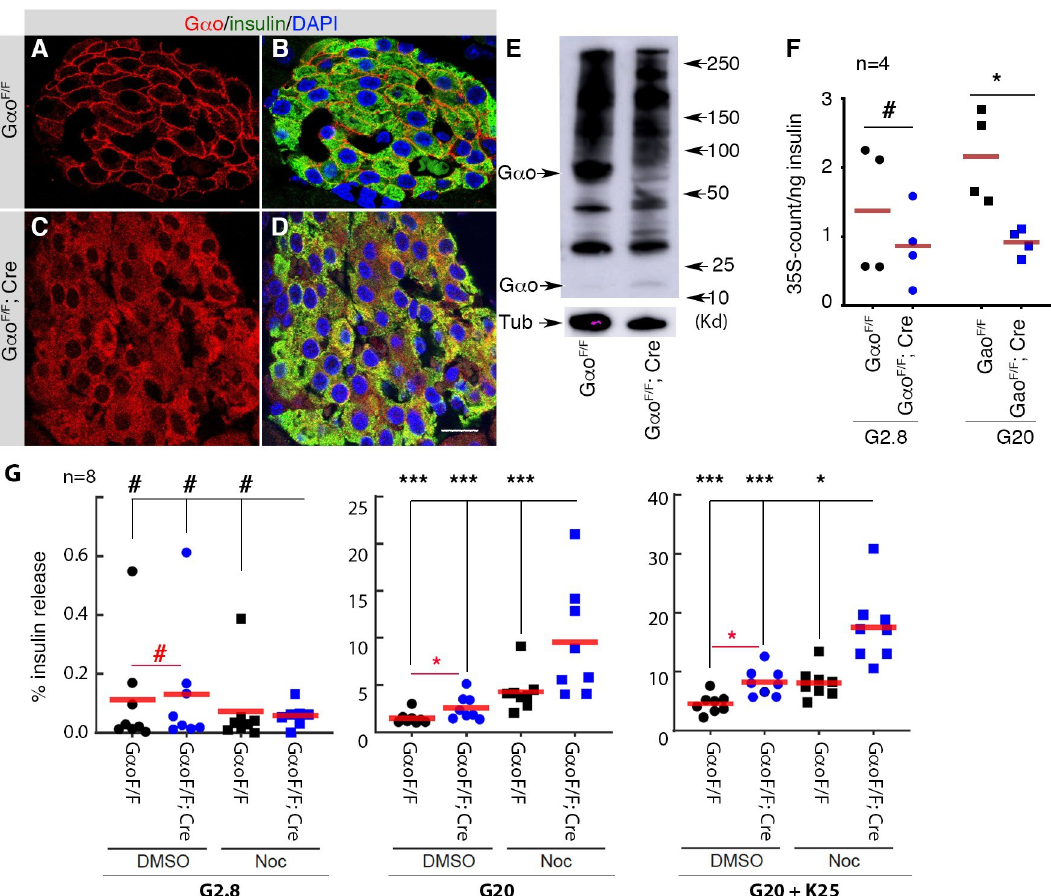
Fig 4. G α o and MT regulate SG secretion via parallel pathways. (A-E) Immunofluorescence and western blot showing G α o inactivation in G α o F/F ; Pdx1 Cre islet cells. Note that Cre-mediated G α o F deletion will yield a mRNA that translates a short N-terminal G α o peptide, recognized by the antibody (red) but has no detectable biological effect [18]. Full length funtional G α o is membrane- bound, while the N-terminal fragment is cytoplasmic, allowing for ready verification of Pdx1 Cre -mediated G α o inactivation in insulin + (green) cells. DAPI (blue) stained for nuclei. Scale bar, 20 μ m. In (E), note the disapearance of G α o full length protein and the appearance of a short G α o fragment in the G α o F/F ; Pdx1 Cre islet samples. Alpha-tubulin was used as loading controls for the western blot. (F) The levels of 35 S-labeling in secreted insulin from control and � : p < 0.05; �� : p < 0.01; ��� : p < 0.001) β cells, prelabeled for four hours. (G) Insulin secretion from G α o F/F ; Pdx1 Cre islets, with or without NOC-treatment, induced by basal G2.8, stimulating G20, and KCl-induced depolarization [(A, B) G20 + K25 (25 mM KCl)]. P values, results from multi-comparison ANOVA or one-way ANOVA (#: p > 0.3. � : p < 0.05; �� : p < 0.01; ��� : p < 0.001). Note the red font “#” or “ � ” in (G) highlight the differences between control and G α o F/F ; Pdx1 Cre islets. Please refer to S1 Table for original numbers used in